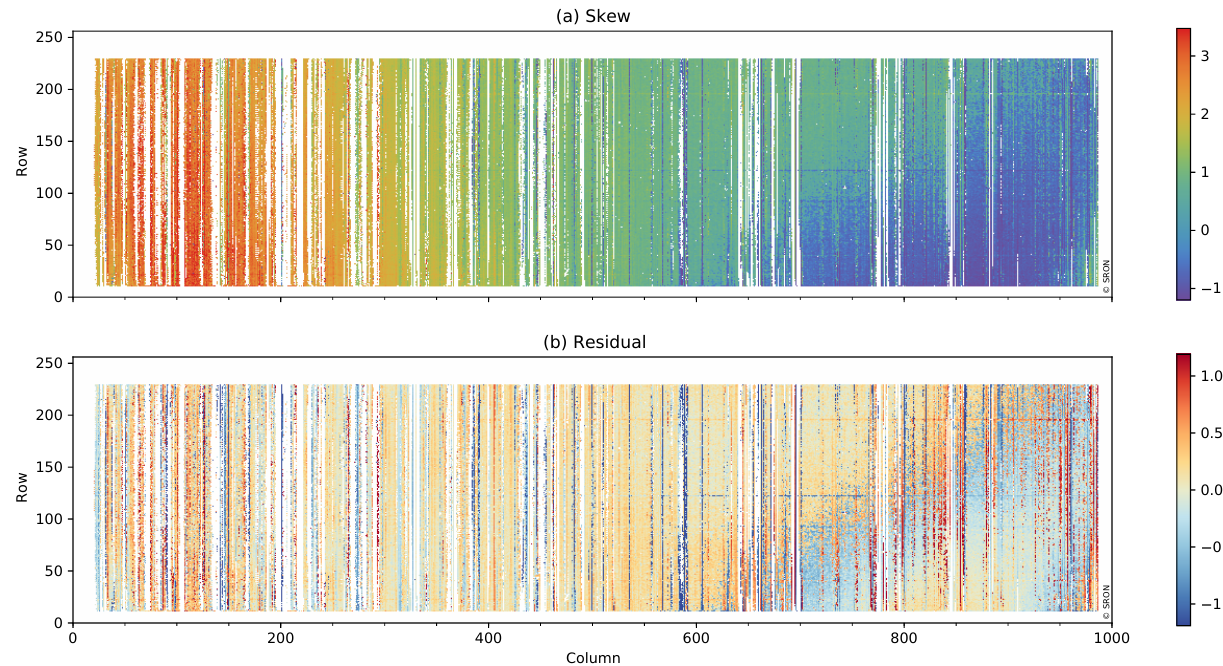
Figure 9. ISRF parameter skew s (irradiance port). Panel (b) shows the difference between s and its bivariate polynomial fit. No measure- ments are performed in the white edges. White vertical stripes are due to saturation in the measurements. Red vertical stripes are due to nearby saturation or laser instabilities.